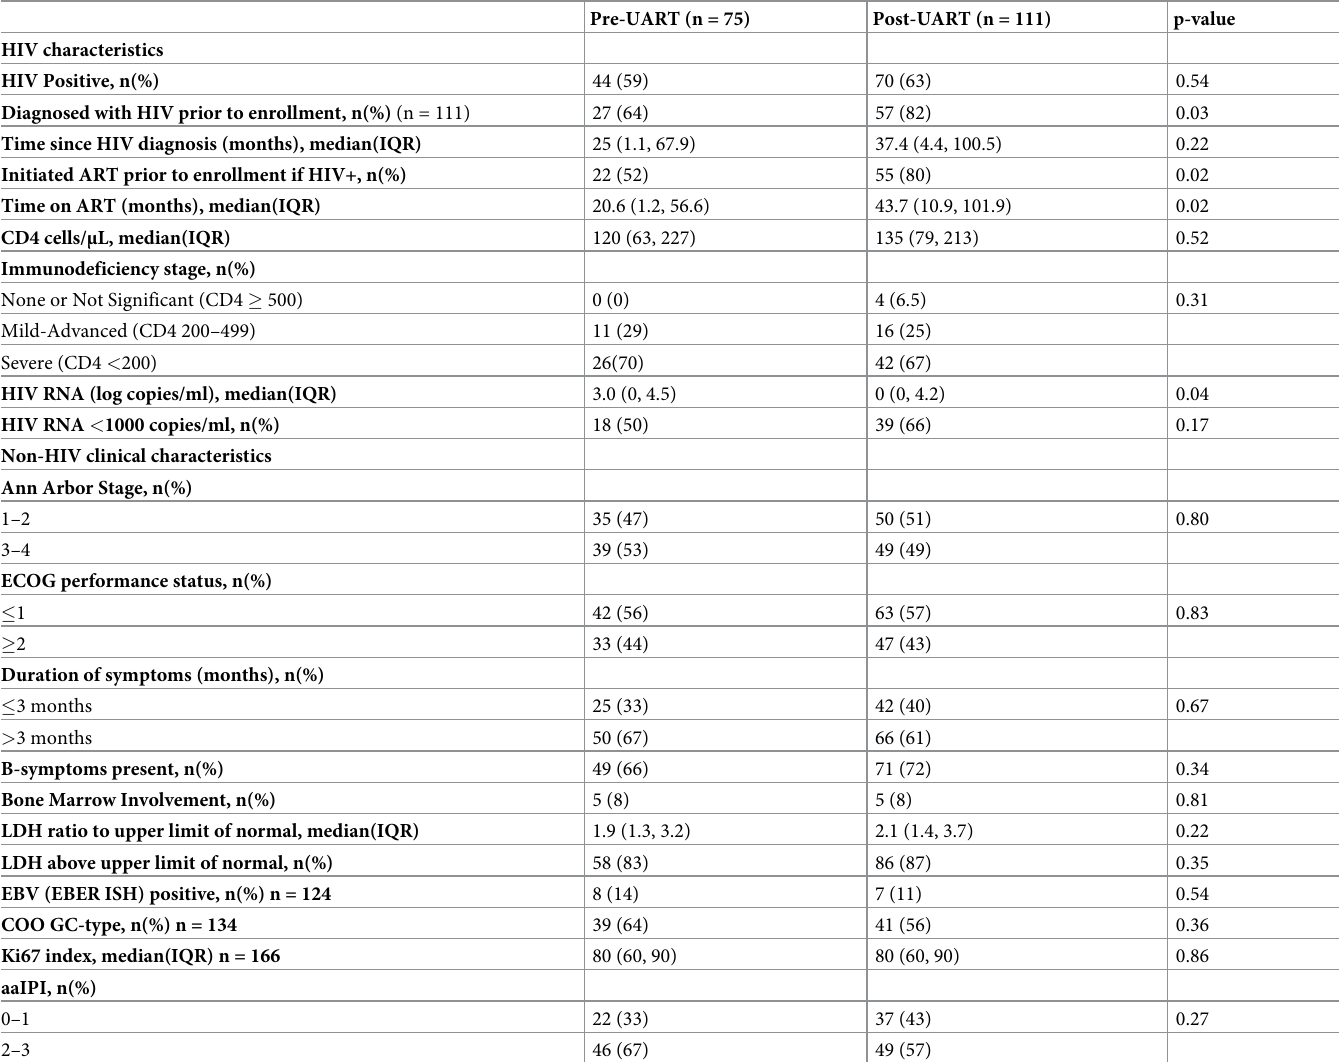
Table 2. DLBCL subset baseline characteristics by pre- and post-universal ART